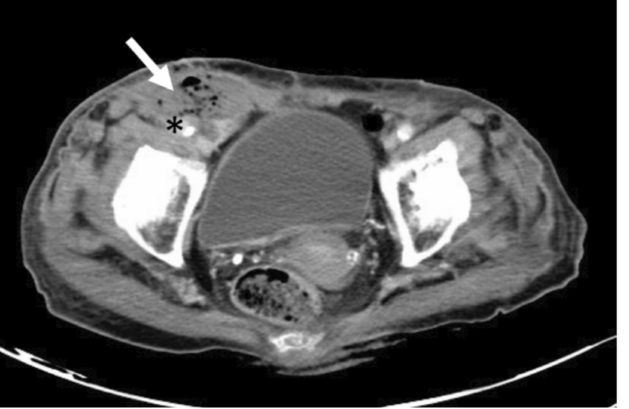
Figure 2. The transverse view of Computed tomography angiography revealed an emphysematous hematoma (arrow) close to right femoral artery